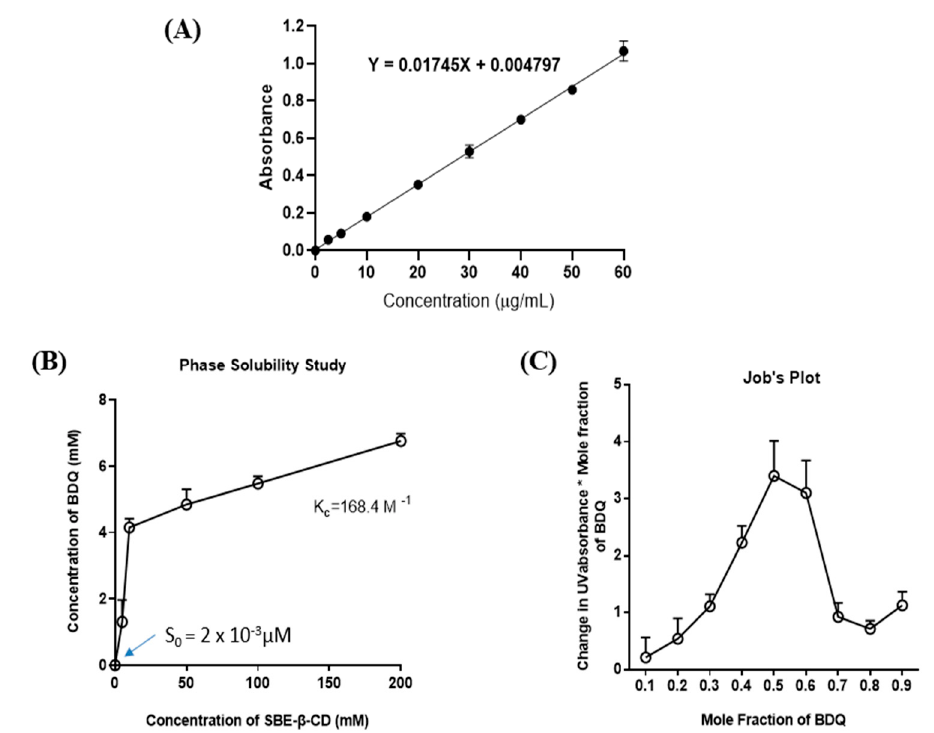
Figure 1. ( A ) Calibration curve for bedaquiline from the standard solutions ranging from 0–60 µ g/mL was plotted by using UV-1600 PC Spectrophotometer at 285 nm. Data represent mean ± SD ( n = 3). ( B ) Phase solubility diagram of bedaquiline in water with Sulfobutyl Ether β -Cyclodextrin (SBE- β -CD). ( C ) Job’s continuous variation plot of bedaquiline-CD complex. Results indicated 1:1 stoichiometry during the formation of inclusion complex. All data represent mean ± SD ( n = 3).